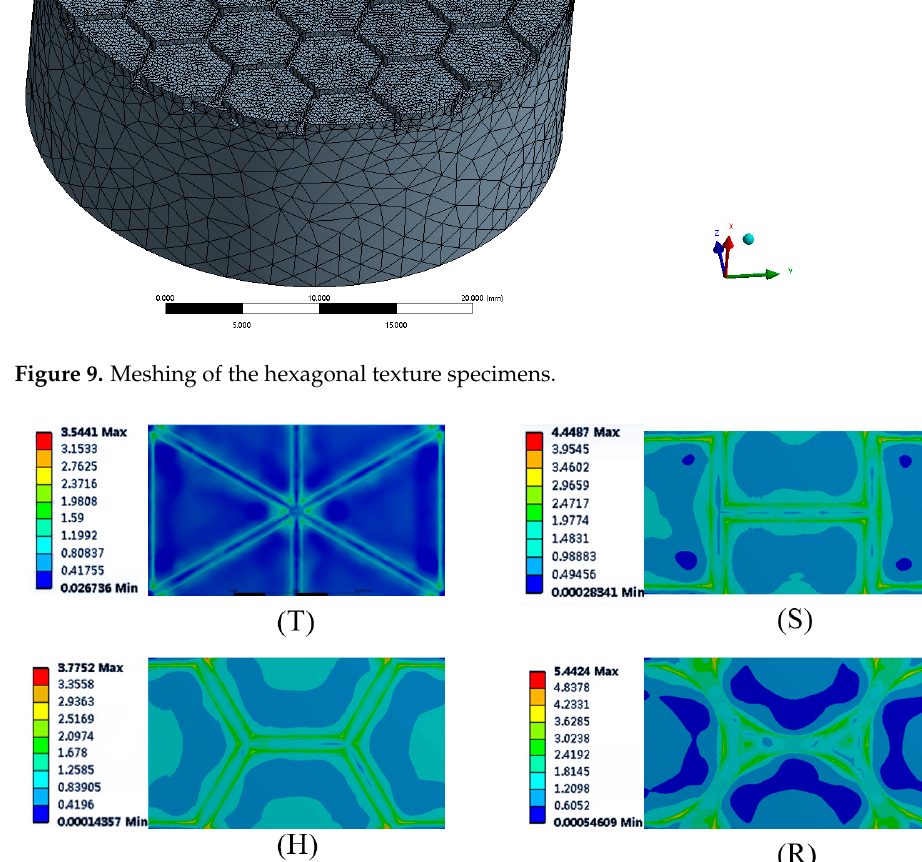
Figure 10. The simulated distribution of equivalent stress on the surface of the four cross-grooved texture units. (T) triangle-textured; (S) square-textured; (H) hexagon-textured; (R) round-textured.